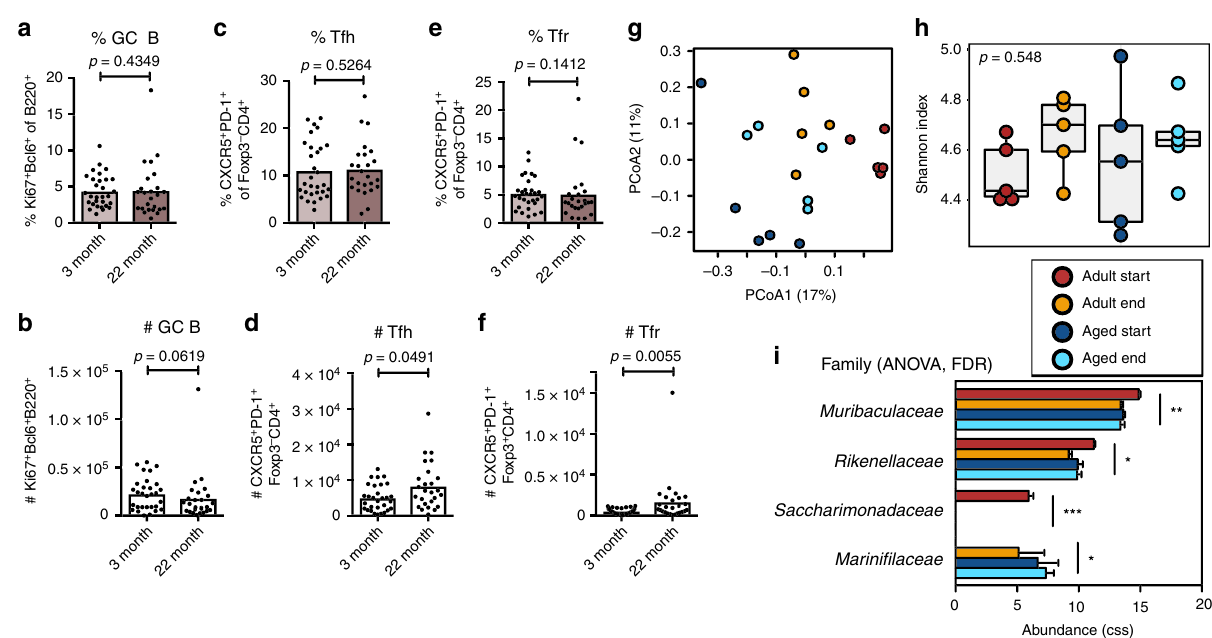
Fig. 4 Co-housing boosts the gut germinal centre response of aged C57BL/6 mice. a – f Adult and aged female C57BL/6 mice were co-housed for 30 – 40 days, then Peyer ’ s patch (PP) germinal centre (GC) cell populations were analysed. The percentage and number of B220 + Ki67 + Bcl6 + GC B cells ( a , b ), CD4 + Foxp3 - CXCR5 + PD-1 + Tfh cells ( c , d ) and CD4 + Foxp3 + CXCR5 + PD-1 + Tfr cells ( e , f ) in Peyer ’ s patches as quanti fi ed by fl ow cytometry. 16S rRNA sequencing data were generated from faecal pellets collected from 5 adult 3-month-old and 5 aged C57BL/6 mice before (start) and after (end) co- housing. Bray-Curtis PCoA ( g ) and Shannon diversities ( h ) of samples collected from adult and aged C57BL/6 mice. The overall p -value was based on ANOVA testing. i Depiction of bacterial families whose abundance was signi fi cantly different between co-housed C57BL/6 mice as determined by